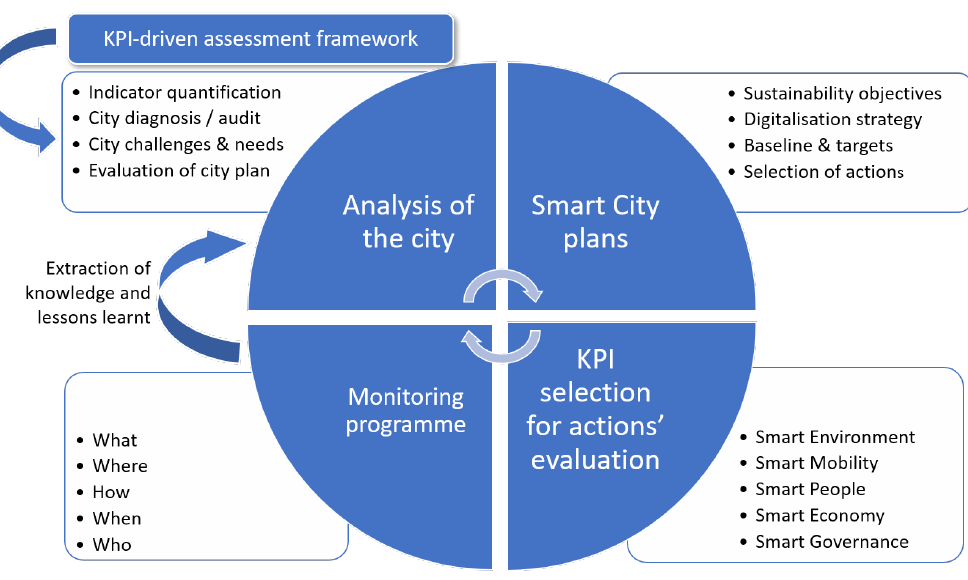
Figure 1. Roadmap for a data-driven sustainable environment